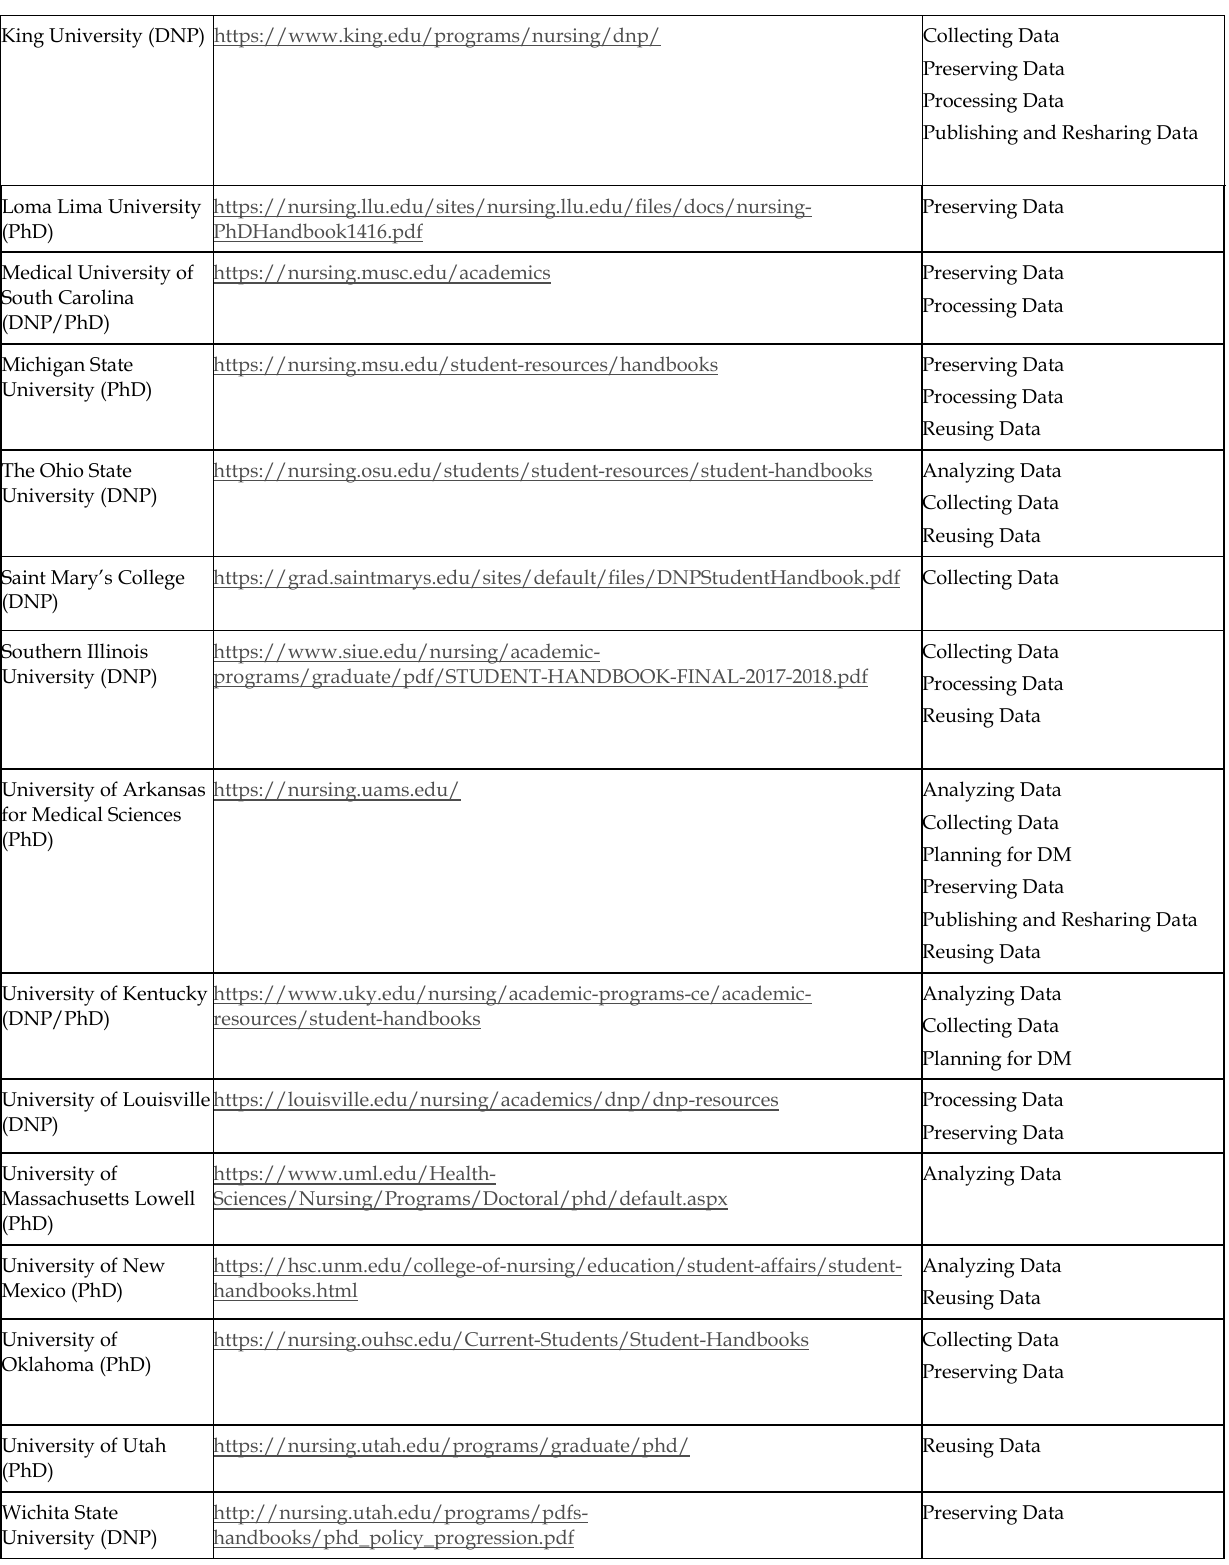
Table 1 Great examples in programs and handbooks (continued) King University (DNP)